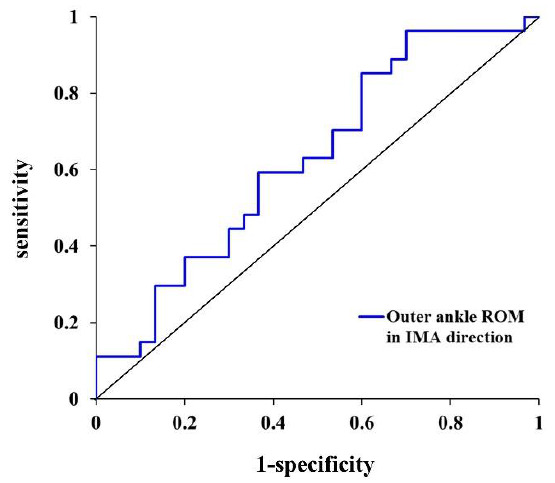
Figure 4. Receiver operating characteristic curve of classifier variable for freezers and non-freezers during the 180° turning task. ROM, range of motion; IMA, inner step of the more affected limb. Table 3. Stepwise binary logistic regression analysis results for freezers and non freezers during the 180° turning task.